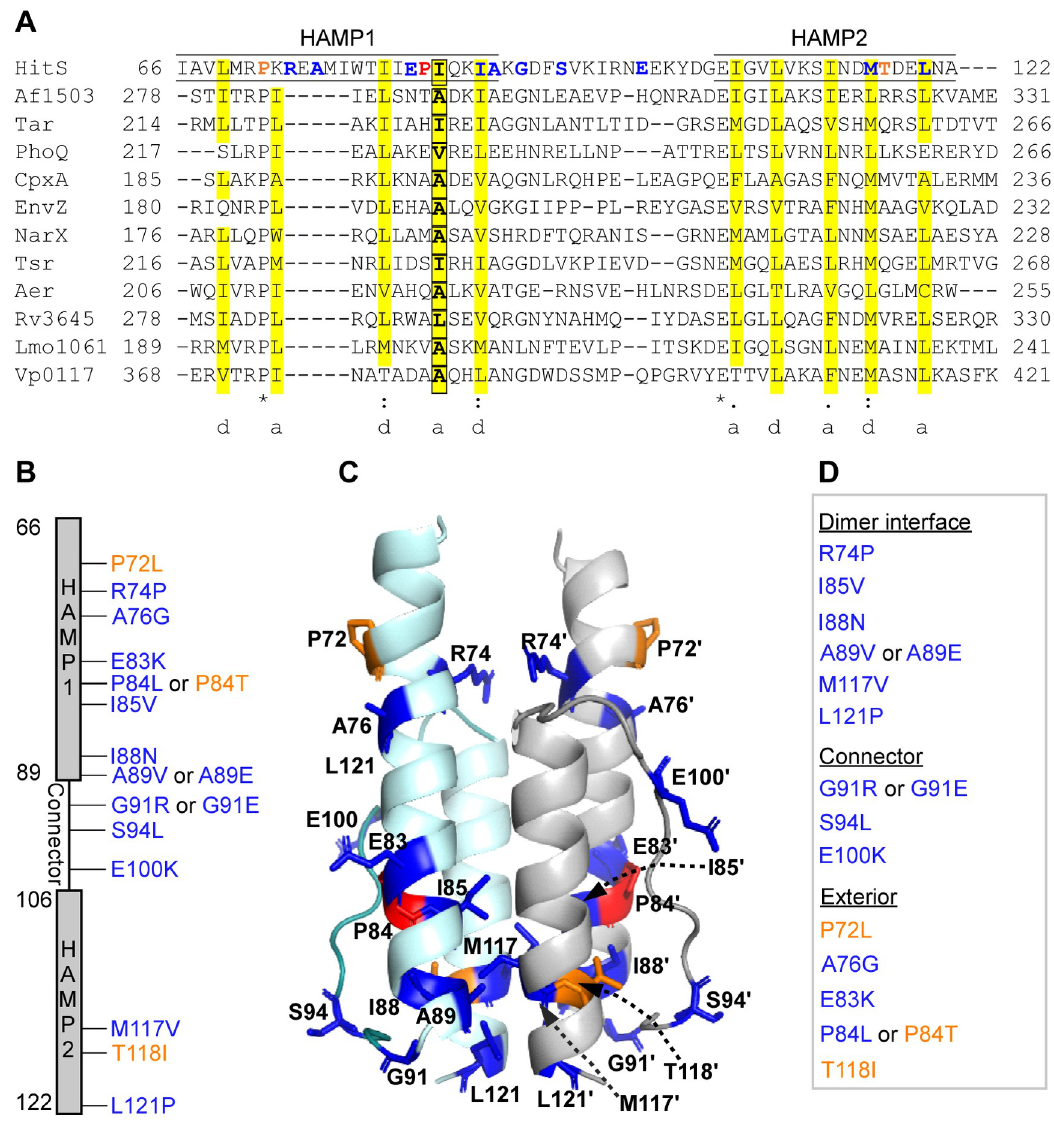
Fig 2. Essentiality of HAMP domain for signal transduction. (A) Multiple HAMP sequences were aligned to display the sequence property and conservation pattern of this domain. The two HAMP helices are underlined. The hydrophobic residues at the a and d positions of the heptad repeat pattern are highlighted in yellow and the residue in HAMP sequence that has been previously reported to be essential for signaling is shown in a box. The residues identified from genetic selections are highlighted in either orange or blue to specify either ON or OFF mutations, respectively. The residue Pro (P84) that can be mutated to either kinase ON or OFF state is highlighted in red. The sequences are from the following: HitS, B . anthracis ; Af1503, A . fulgidus ; Tar, E . coli ; PhoQ, E . coli ; CpxA, E . coli ; EnvZ, E . coli ; NarX, E . coli ; Tsr, E . coli ; Aer, E . coli ; Rv3645, Mycobacterium tuberculosis ; Lmo1061, Listeria monocytogenes ; Vp0117, Vibrio parahaemolyticus . (B) All mutations isolated from genetic selections: OFF mutations are shown in blue while ON mutations are shown in orange. (C) All mutations are mapped onto the homology model based on A . fulgidus Af1503 (PDB ID: 4GN0). (D) All mutations were categorized into three groups based on their location in the homodimeric four- helix